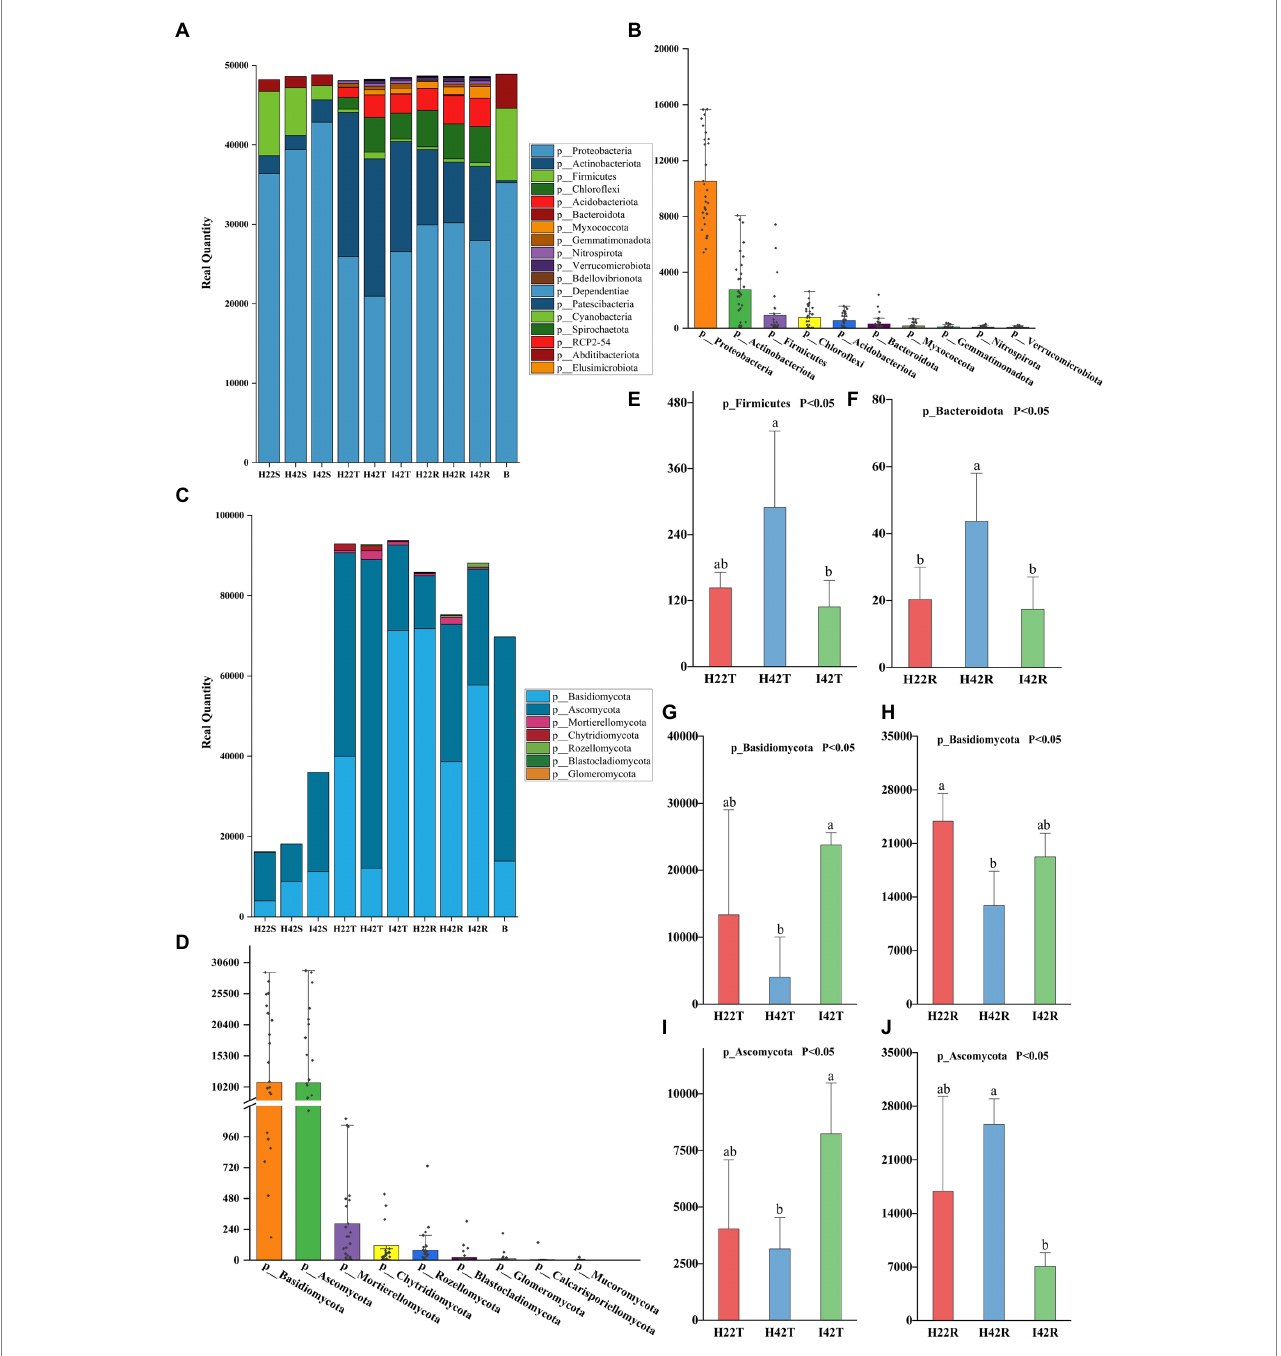
FIGURE 1 Composition of microbiota phylum levels. (A) Histogram of species stacking at the bacterial phylum level for experimental samples. The figure shows the full phylum-level microbiome obtained from the annotation, with the number percentages indicated by the length of the bars in the figure. (B) Histogram of the percentage of major species at the phylum level of the bacterial microbiome. The figure shows the distribution of individual samples at the major phylum level microbiomes, arranged in descending order of total sample species abundance. (C) Histogram of species stacking at the fungal phylum level for experimental samples. (D) Histogram of the percentage of major species at the phylum level of the fungal microbiome. (E-J) The gate-level microbiome that showed the expected significant level of difference in resistance associated with the different experimental subgroups. Error bars indicate standard deviation (+/–SD) and letters indicate differences between each subgroup. Differences were significant at the p ≤ 0.05 level calculated using the chi-squared test